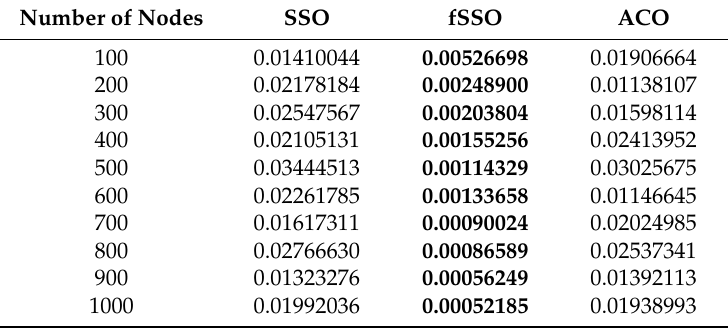
Figure 10. Standard deviation of the fitness values for ten benchmarks. Table 13. Maximum of fitness values of fSSO compared with SSO and ACO for ten benchmarks.